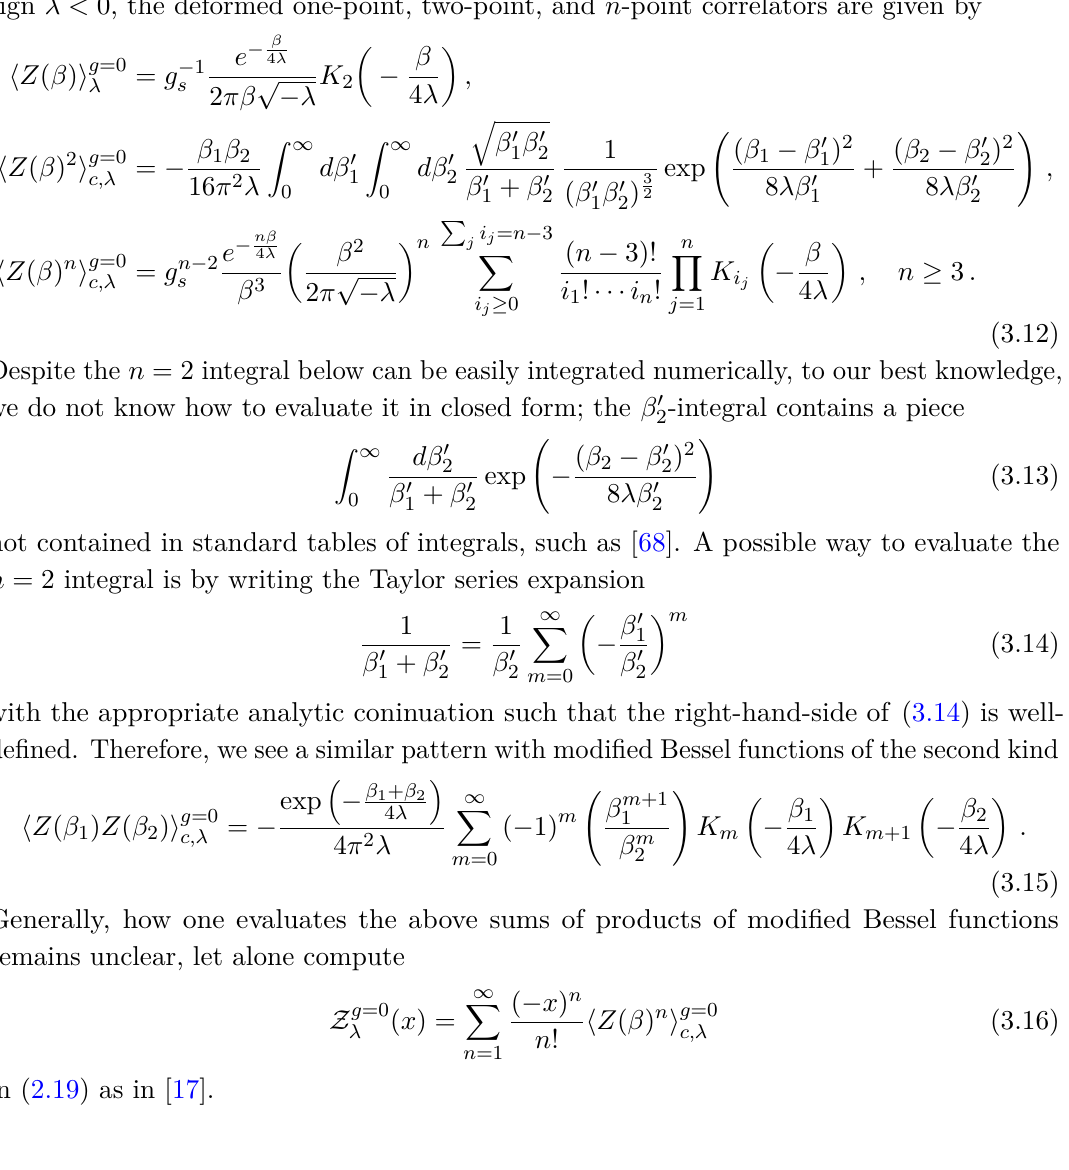
. It in fact has a constant negative i